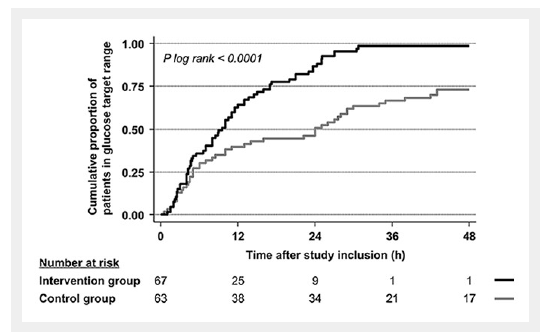
Effect of the intervention on time in glucose target range (5.5–7.0 mmol/l) overall and in subgroups. All models of multivariate analyses were adjusted for age, gender, body mass index (BMI), glucocorticoid use and previously known diabetes. CI = confidence interval.